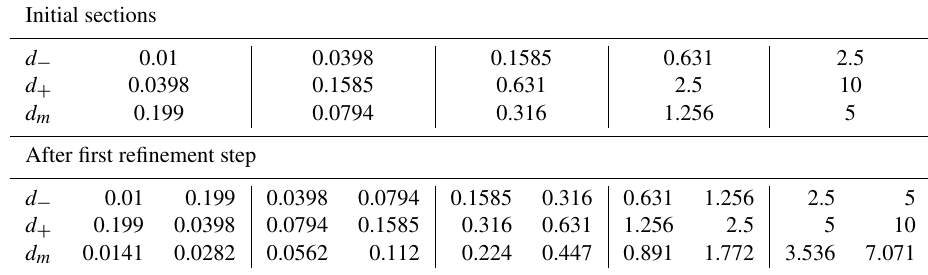
Table A1. Diameters (in µm) of the different sections both initially and after the first refinement step.